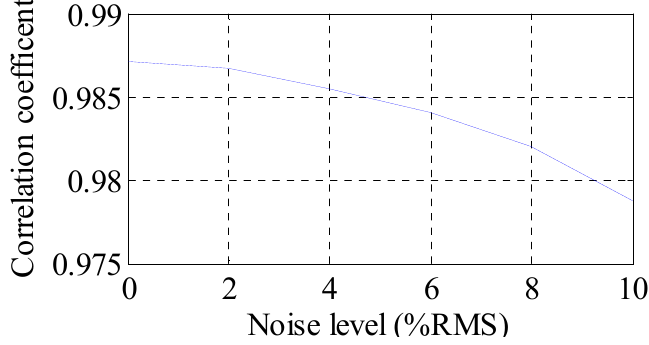
Figure 12. Reconstruction performance measured in correlation coefficient under different noise levels.